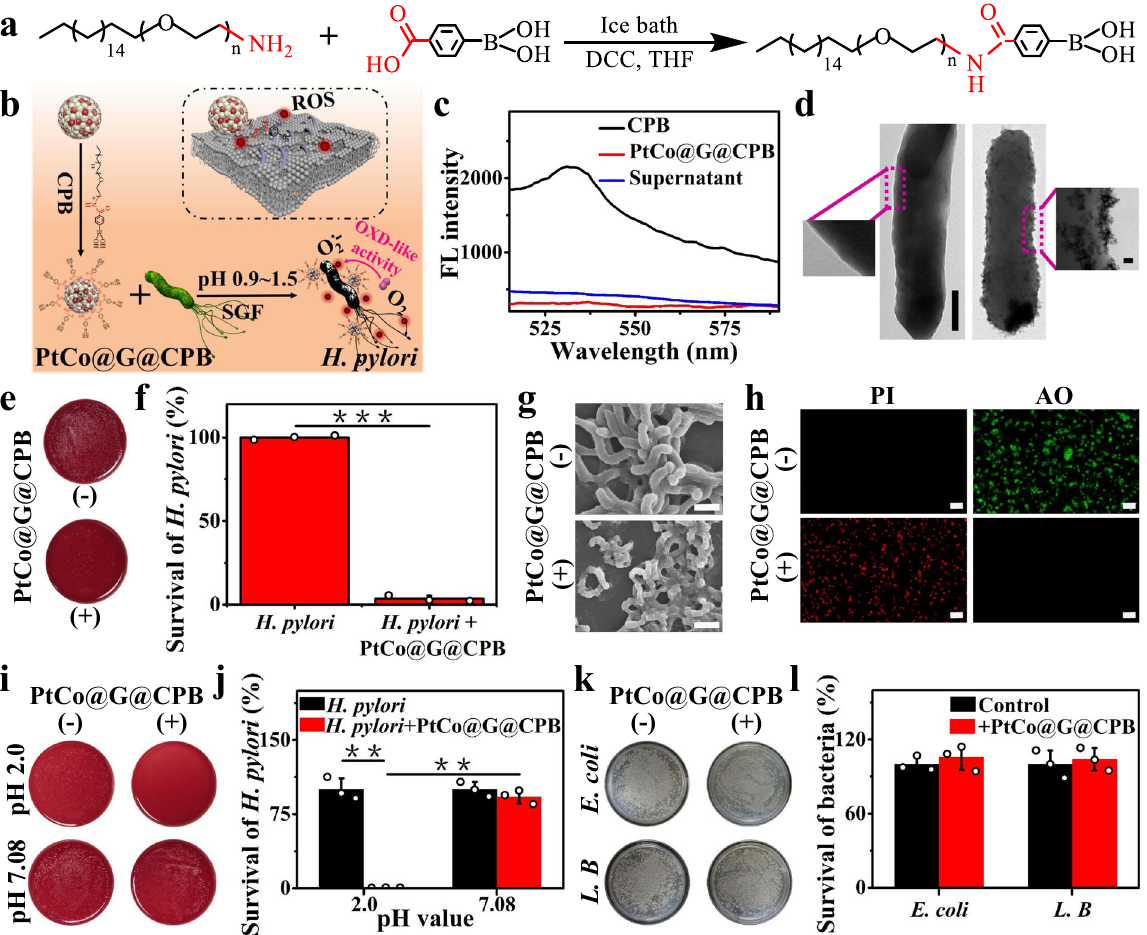
Fig. 2 C 18 -PEG n -benzeneboronic acid (CPB) synthesis and PtCo@G@CPB selective treatment of H. pylori in vitro. a Schematic illustration of C 18 -PEG n - Benzeneboronic acid synthesis. b Schematic of CPB modi fi ed PtCo@G nanocrystals and antibacterial mechanism of PtCo@G@CPB against H. pylori . c Fluorescence spectra characterization of CPB functionalized PtCo@G. d TEM images showing the ability of PtCo@G@CPB to target H. pylori. H.